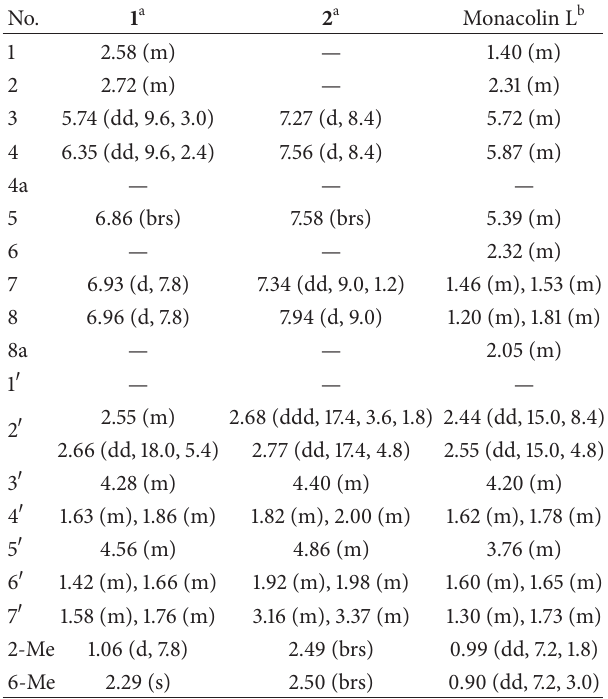
Table 1: 1 H NMR (600MHz) data for 1 , 2, and monacolin L ( 𝛿 in ppm, 𝐽 in